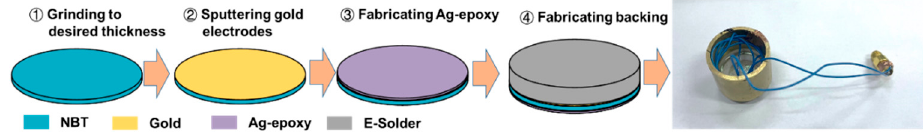
Figure 8. Fabrication process of the BNT-6BT ultrasonic transducer.